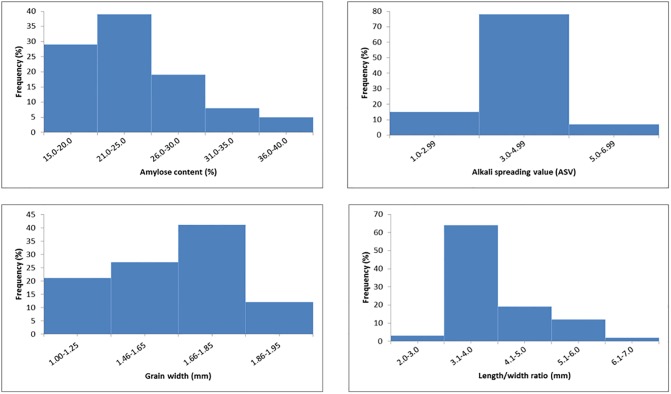
Phenotypic distribution of GWAS results for grain quality traits (AC, amylose content; ASV, alkali spreading value; GW, grain width; L/W, grain length to width ratio); grain shape (length/width ratio): slender≥3.0; Medium = 2.1–3.0; Bold = 1.1–2.0; Round<1.1; Grain length: Extra-long(≥7.5 mm); Long (6.6–7.5 mm); Medium (5.51–6.6 mm); Short (<5.51mm).